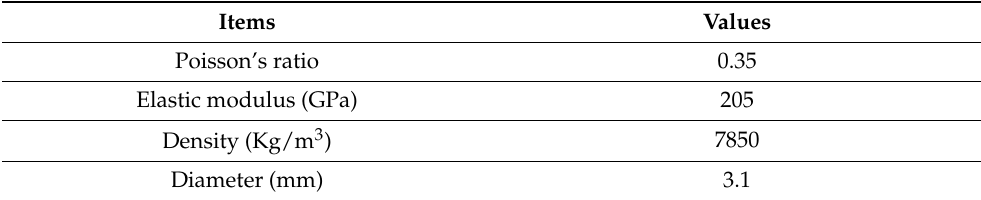
Table 1. Material properties of the SWO-V specimen.